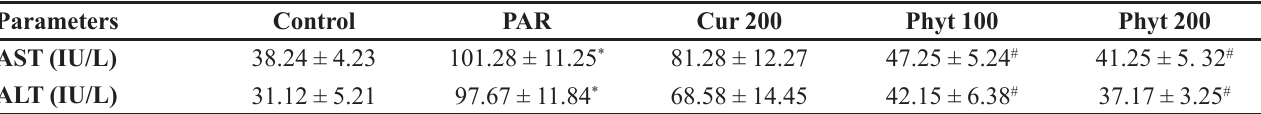
TABLE IV - Effect of phytosome curcumin on liver marker enzymes Parameters